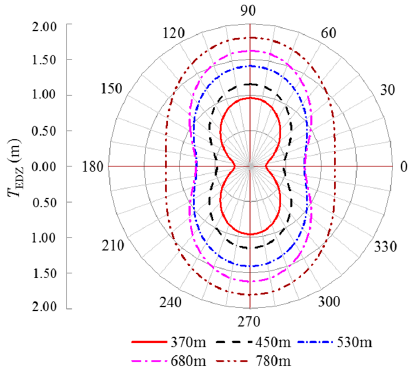
Figure 5. The thickness of EDZs based on the Mohr–Coulomb criterion.